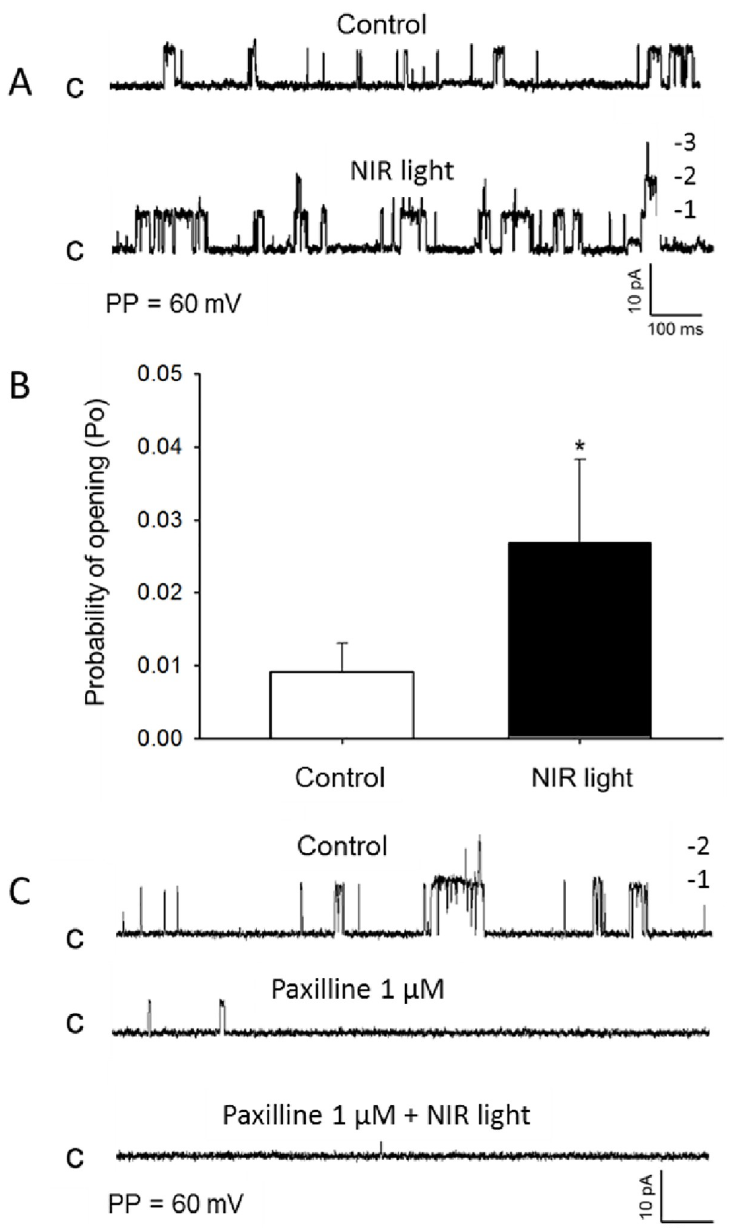
Fig 4. R/NIR increases the opening frequency and open state probability of the BK Ca channel. Exposure to NIR light induced marked increase in opening frequency and probability of opening (Po) (A and B) of a 273 pS BK Ca single-channel current recorded from cell attached patches of wild type mice isolated femoral arterial smooth muscle cells at a patch potential of +40 mV using symmetrical 145 mM KCl recording solution (n = 20 cells from 7 mice, � p < 0.05). Pretreatment of the cell-attached patches with the specific BK Ca channel current inhibitor paxilline (1 μ M) prevented the NIR induced increase in the opening frequency of the BKCa single-channel currents